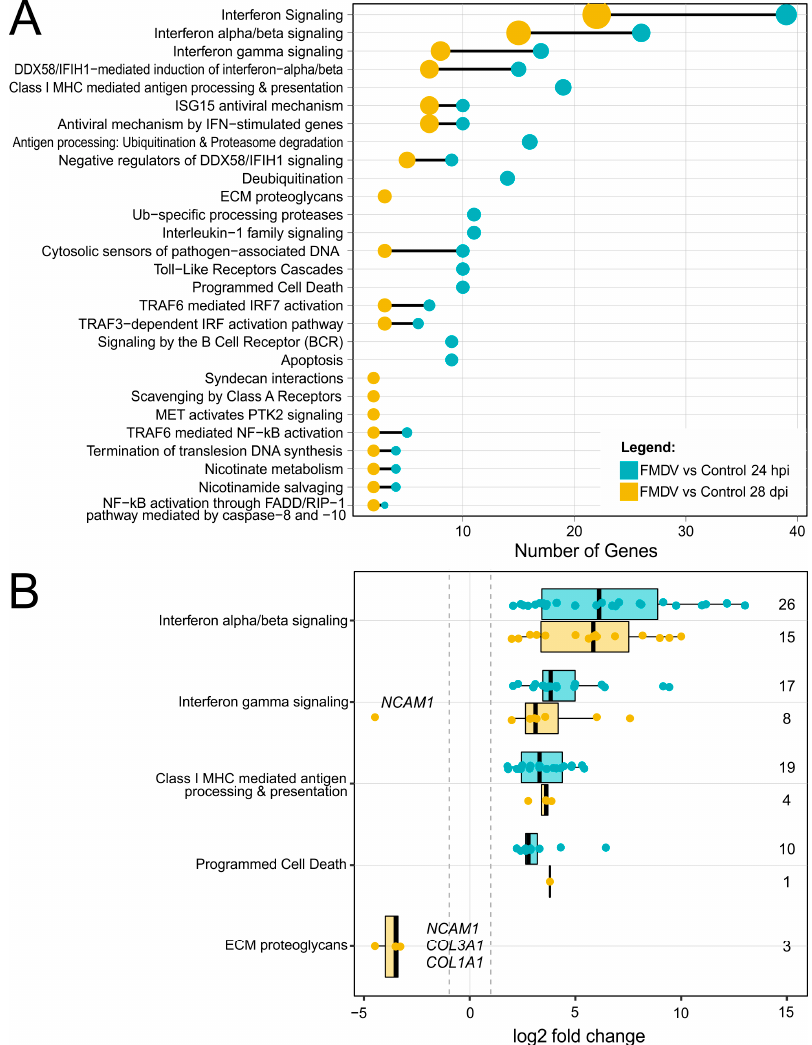
Figure 3. Pathway enrichment analyses of significantly differentially expressed genes during acute and persistent FMDV infection of bovine soft palate cells. ( A ) The number of genes that contribute to a significantly enriched Reactome pathway is shown for 24 hpi (blue dots) and 28 dpi (orange dots). Black lines connect pathways that are enriched in both datasets and the size of the circles represents the ratio of genes found for a certain pathway to the overall gene number. ( B ) The log2 fold change of genes that contribute to selected enriched Reactome pathways are highlighted (24 hpi—blue dots) and 28 dpi—orange dots). The grey dotted lines indicate a |log2 fold change| > 1. The numbers on the right correspond to the number of genes associated with each pathway. Table 1. Genes that are differentially expressed only during the persistent phase of FMDV infection.